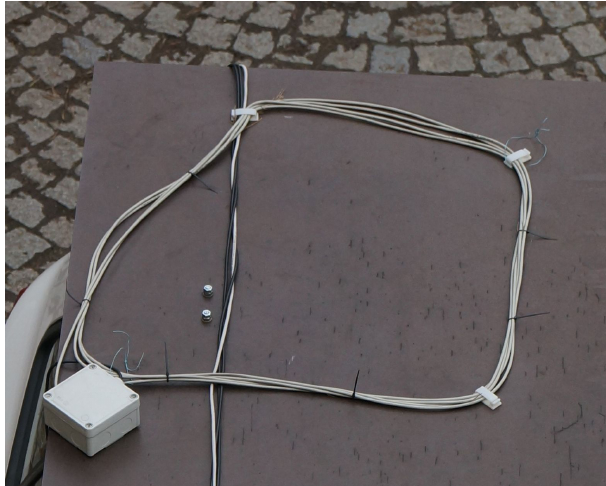
Figure 3. The STP loop antenna, mounted on the CAR1, has a res- onant frequency of 100kHz. Its signal was directly sampled by an oscilloscope placed inside the car.